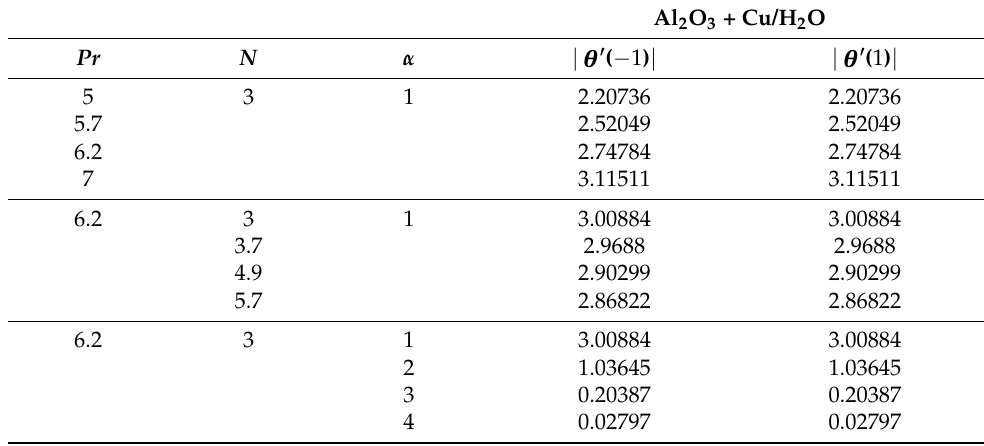
Table 5. Heat transfer rates at the lower and upper disks for Al 2 O 3 + Cu/H 2 O HN fd .